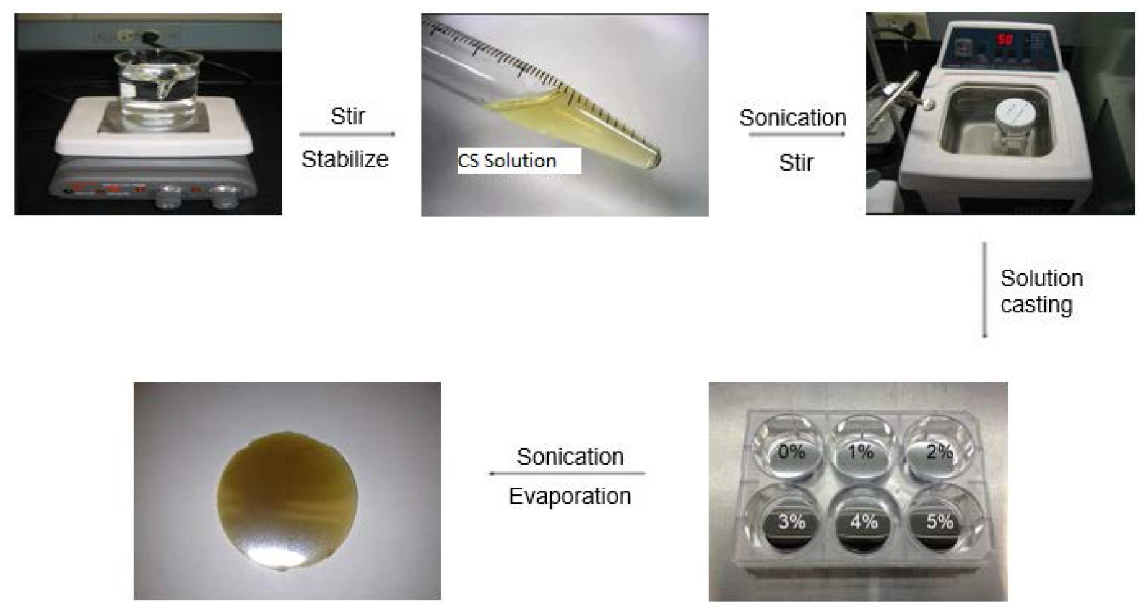
Figure 9. A generalized method for the synthesis of chitosan films (taken from [19] under Creative Commons License).